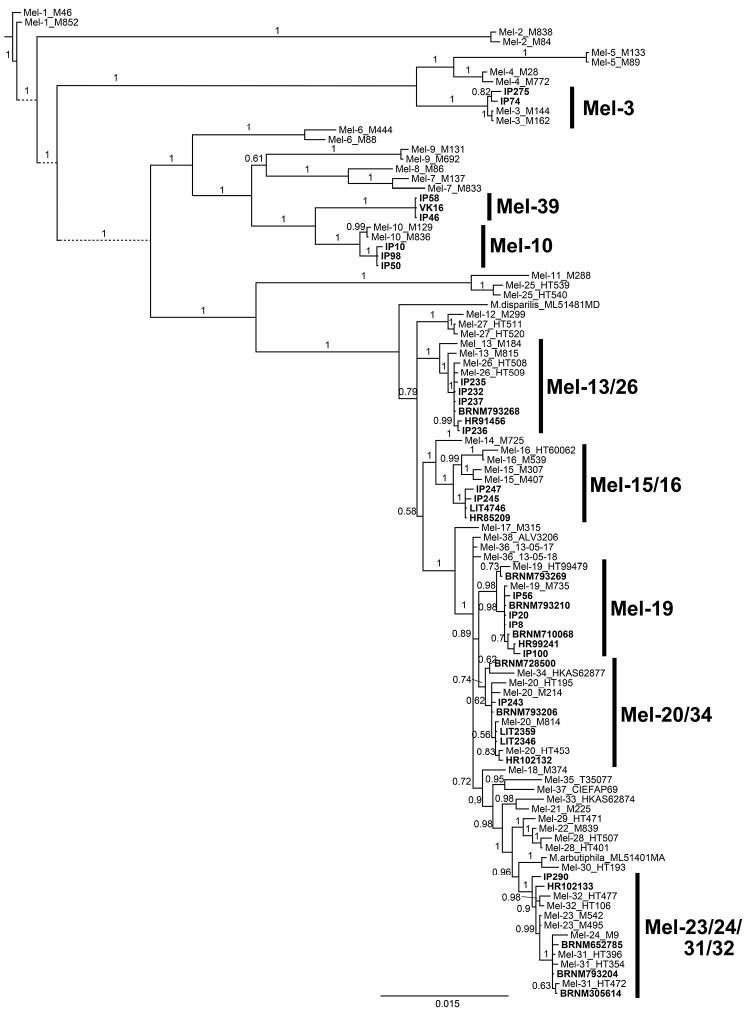
Bayesian phylogeny inference tree based on five-gene concatenated alignment from selected accessions of the Elata Clade. Posterior probabilities (PP) are shown above branches, splits with PP < 50% were collapsed.